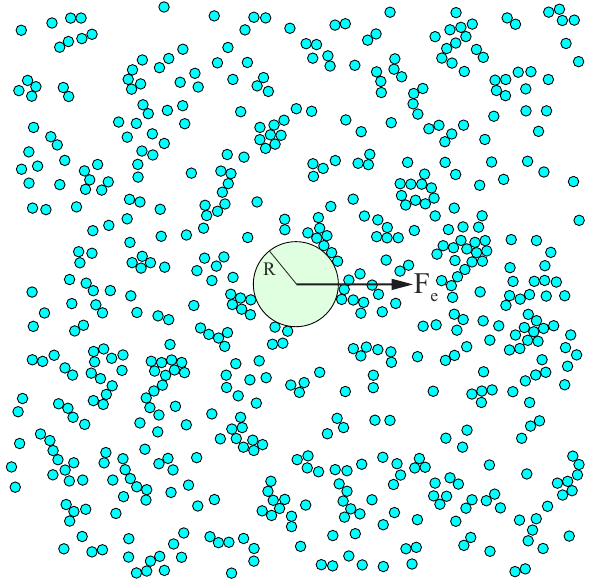
F e ( t ) e x through a bath =